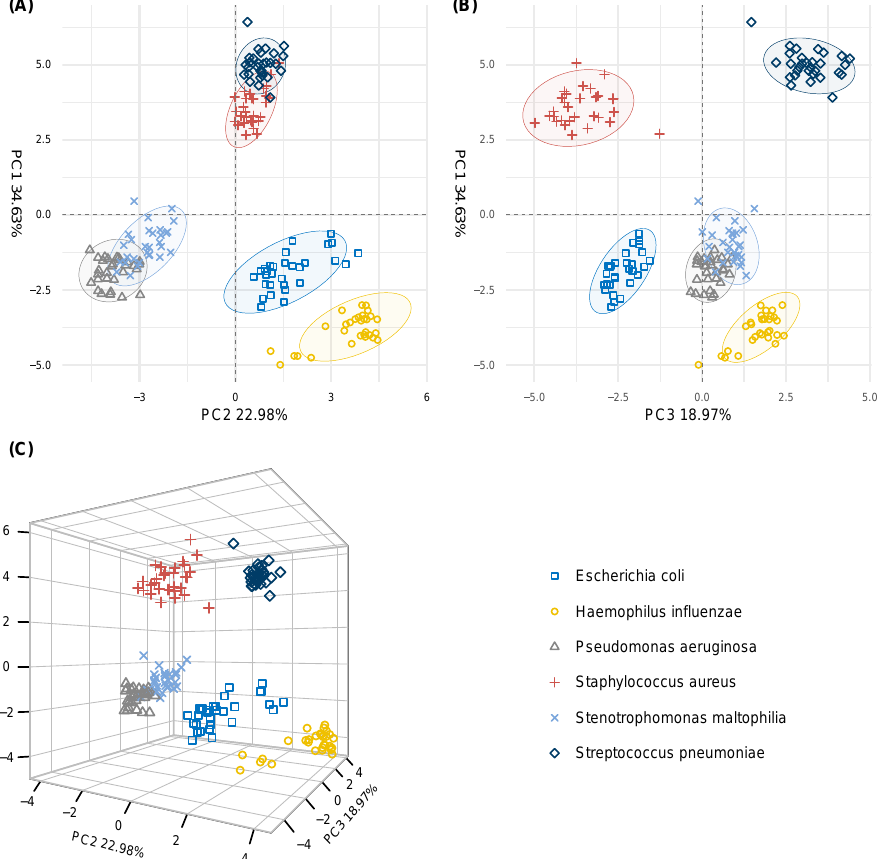
Figure 3. Principal component scores plots of the 6 pathogen groups generated by the selected 31 m / z -representants. ( A ) PC scores plot of the first two principal components (58.49%). ( B ) PC scores plot of the first and third principal component (52.84%). ( C ) three-dimensional representation of the first three principal components scores. Same coloring and data ellipses were added as in Figure